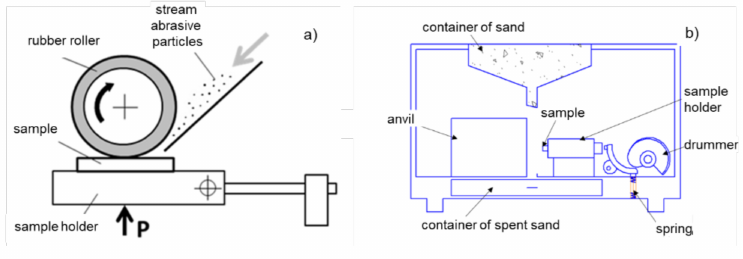
Figure 2. The experimental test stand for testing of samples: ( a ) abrasive wear according to the “rotating roller–flat surface” scheme; ( b ) impact and abrasive wear.